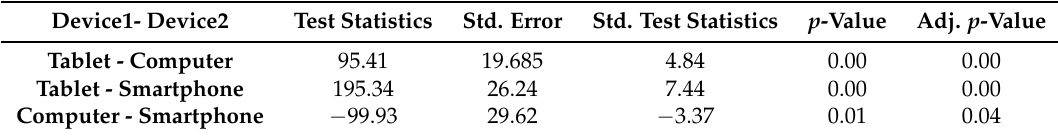
Table 8. Values of the Kruskal-Wallis statistical test and the Bonferroni post-hoc test related to the differences between the number of failed subjects and the type of device used to access the LMS.